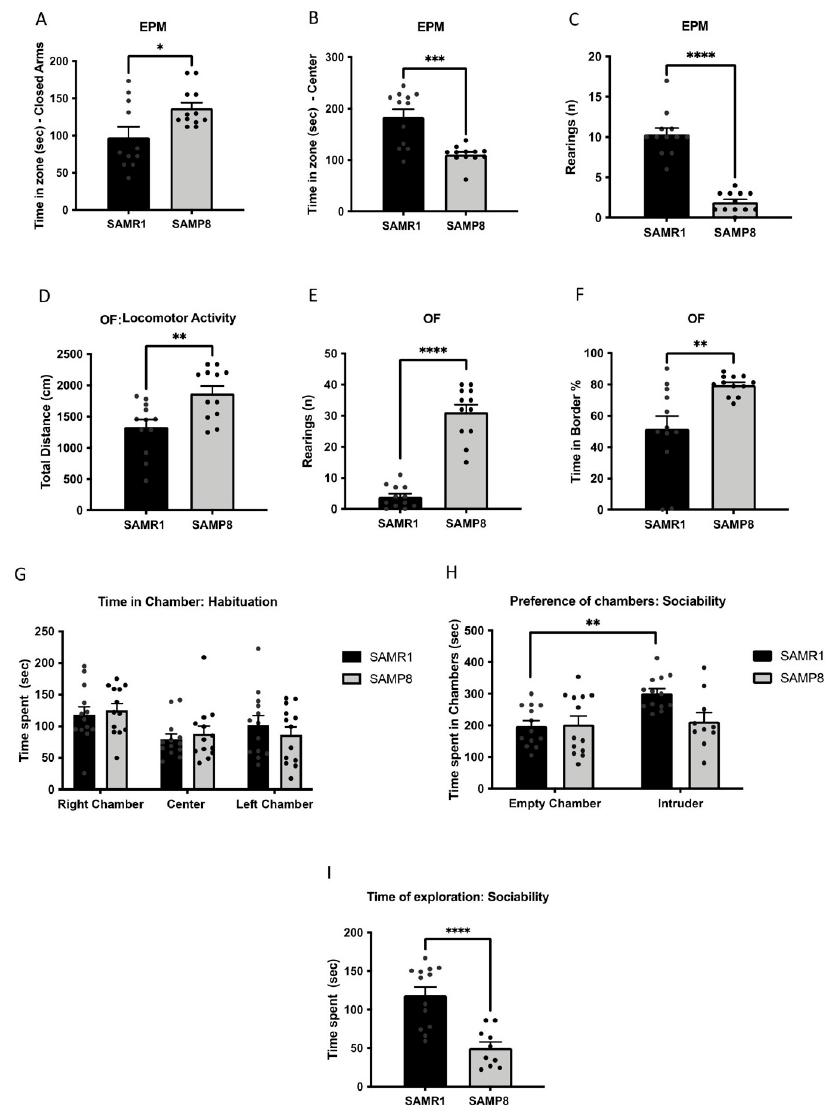
Figure 1. Results of the elevated plus maze (EPM) and open field (OF) tests in male SAMR1 and SAMP8 mice at 12 months of age. For EPM: time spent in closed arms ( A ), time spent in centre ( B ) and number of rearings ( C ). For OF: total distance ( D ), number of rearings ( E ) and time spent in the border zone ( F ). Results of the three-chamber test (TCT) in aged SAMR1 and SAMP8 male mice. Habituation ( G ), preference for chambers ( H ) and exploration time ( I ). Bars show the mean ± SEM (for EPM and OF: n = 11–12 mice per group; for TCT n = 13–10 mice per group). Statistical tests: t-Student analysis ( A – G , I ); two-way ANOVA followed by Šídák’s post hoc test ( H ). * p < 0.05; ** p < 0.01; *** p < 0.001; **** p < 0.0001.